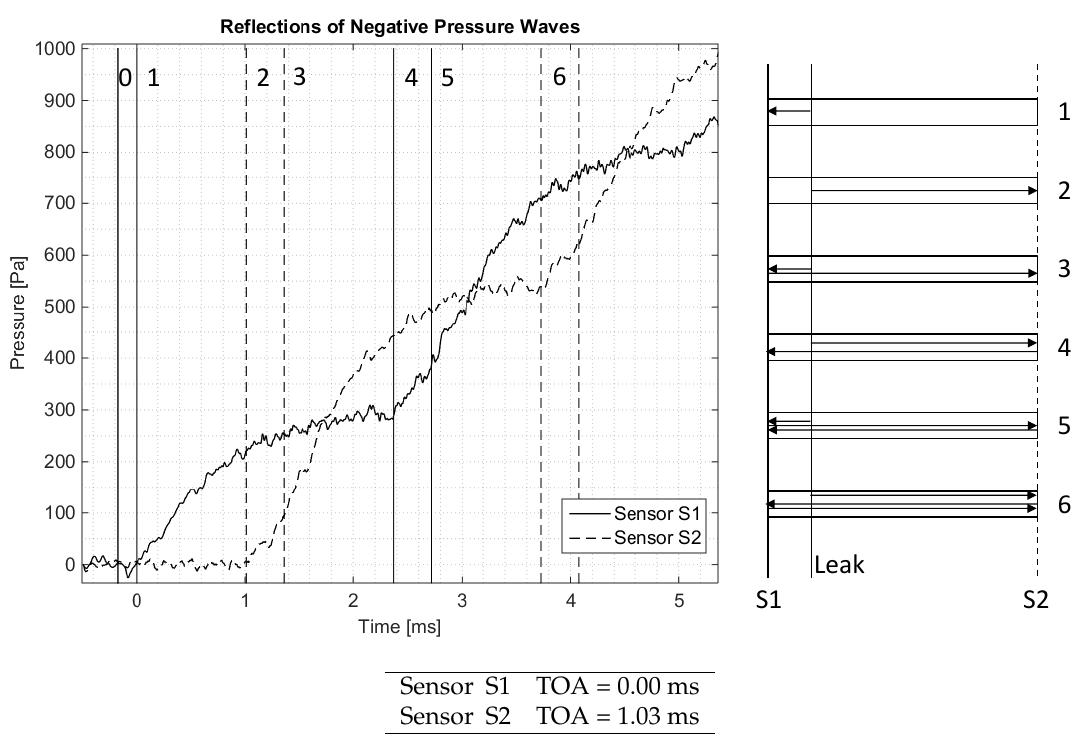
Figure 6. Time-of-arrival of the (reflections of) negative pressure